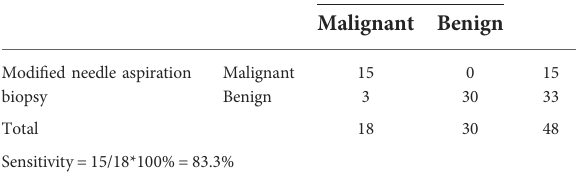
Pathological Total diagnosis of lymphadenectomy Malignant